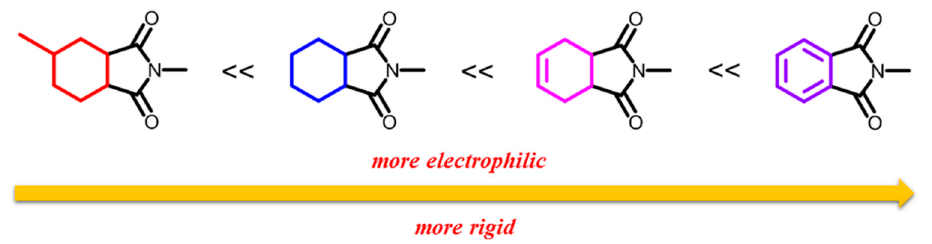
Polymers 2018 , 10 , x FOR PEER REVIEW 9 of 16 Figure 5. DSC thermograms of ortho -imide functional benzoxazine monomers. It is generally expected that the melting temperature rises as the rigidity of monomers increases. According to the rigidity order, 4-methyl-hexahydrophthalimide < hexahydrophthalimide